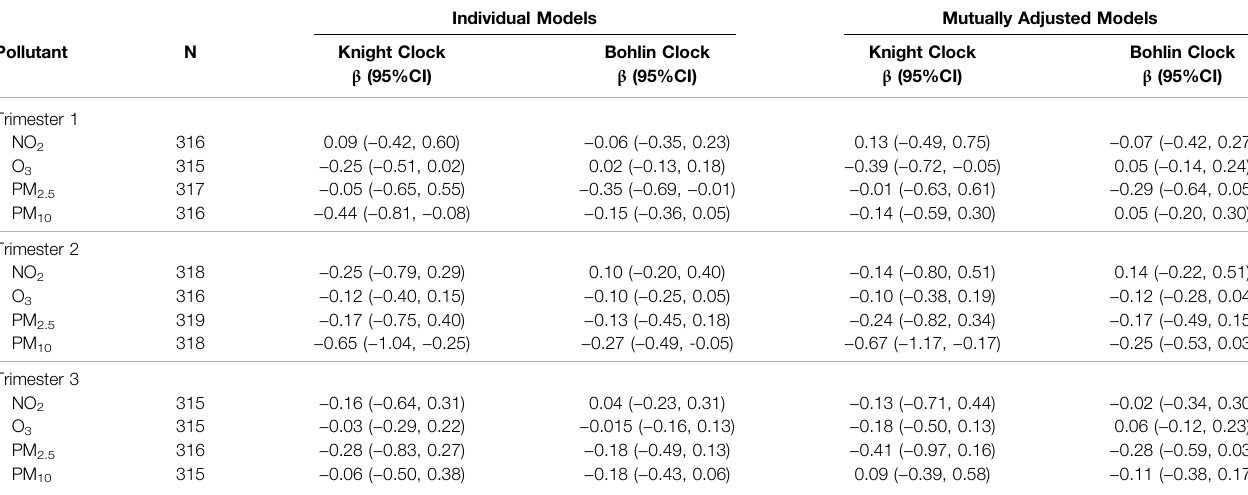
TABLE 3 | Association of trimester-speci fi c and preconception average ambient air pollution and epigenetic aging at birth. Individual